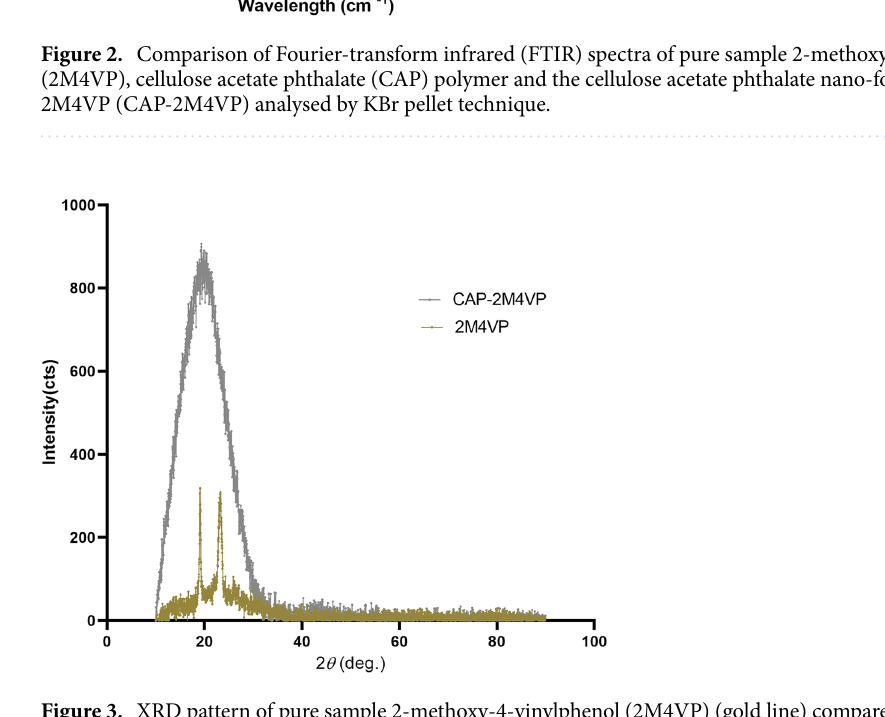
Figure 3. XRD pattern of pure sample 2-methoxy-4-vinylphenol (2M4VP) (gold line) compared to the cellulose acetate phthalate nano-formulation of 2M4VP (CAP-2M4VP) (grey line) indicating the